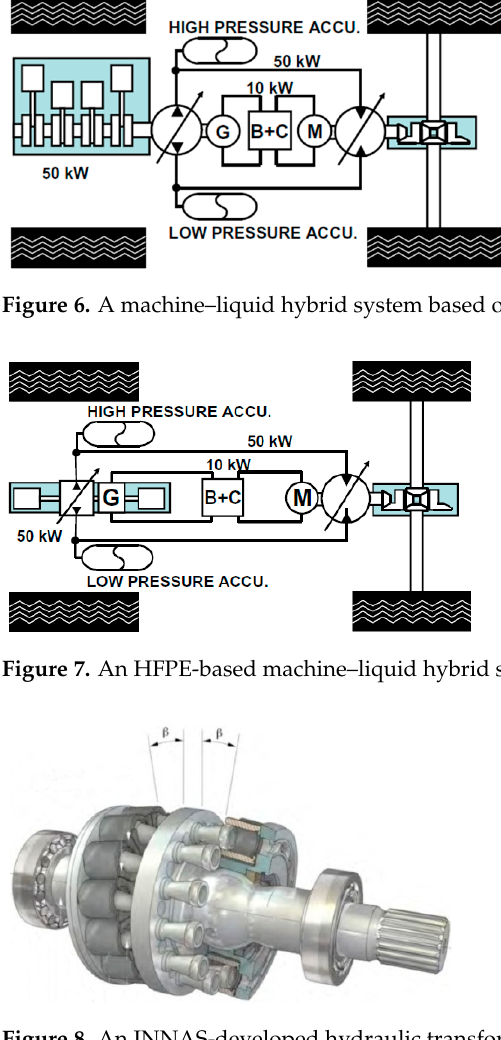
Figure 8. An INNAS-developed hydraulic transformer [17].